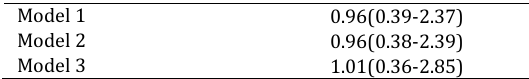
Table 2. Hazard ratio with 95% CI for coronary heart disease in subclinical hyperthyroid group.